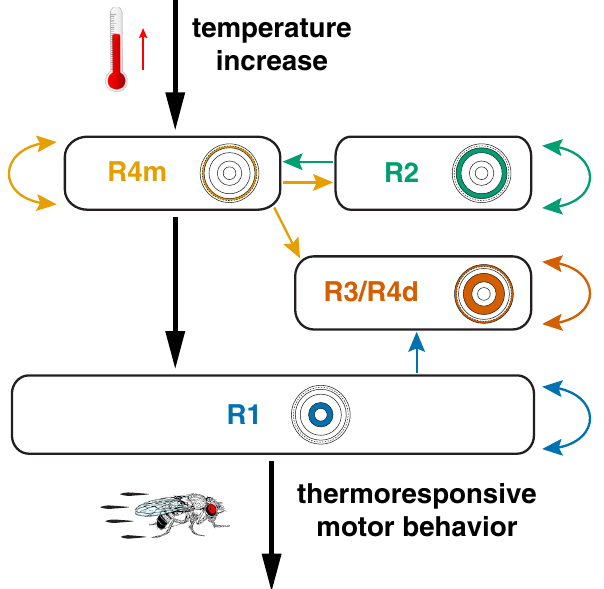
Figure 8. Summary of findings and proposed model. Segregated ring neuron circuit activities mediate sensory- motor transformation whereby R4m neurons integrate and convey warming-related temperature changes above 25 °C to R2–R4 circuits. R1 acts as the bona fide output layer gating thermoresponsive motor behavior in Drosophila